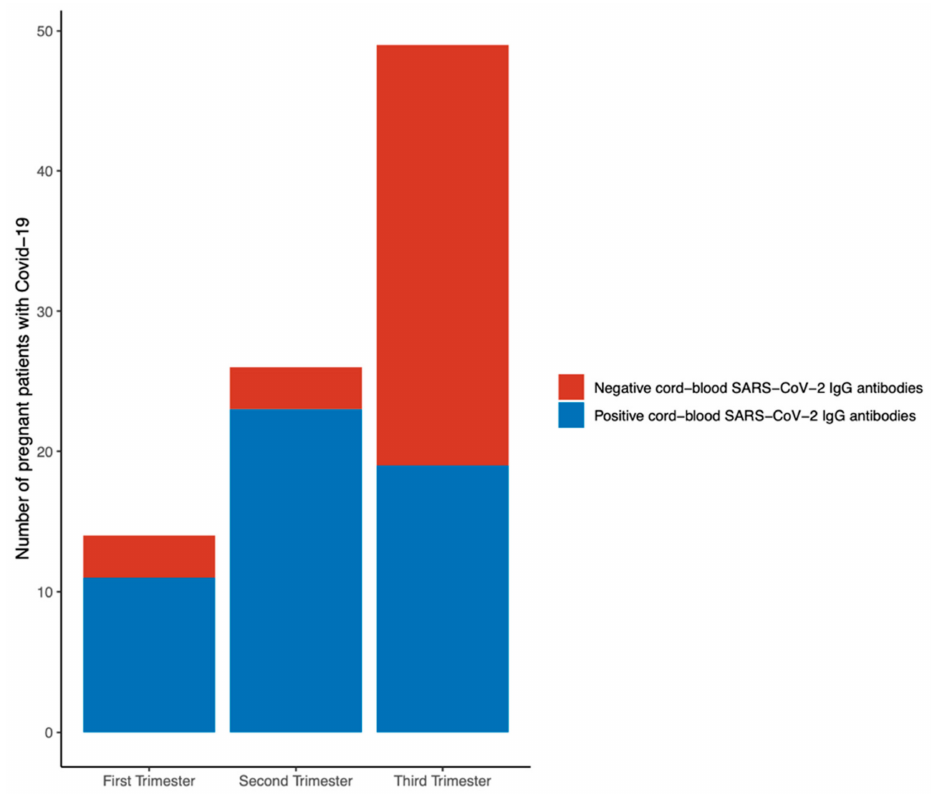
Figure 1. Cord-blood SARS-CoV-2 IgG antibody seropositivity of newborns from pregnant women with SARS-CoV-2 infection during the indicated trimester of